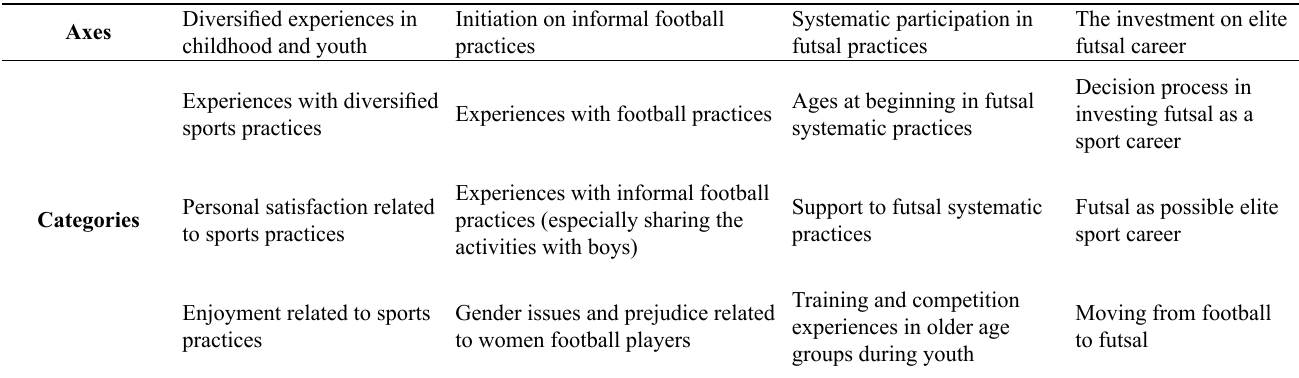
Table 2: Axes and categories Axes